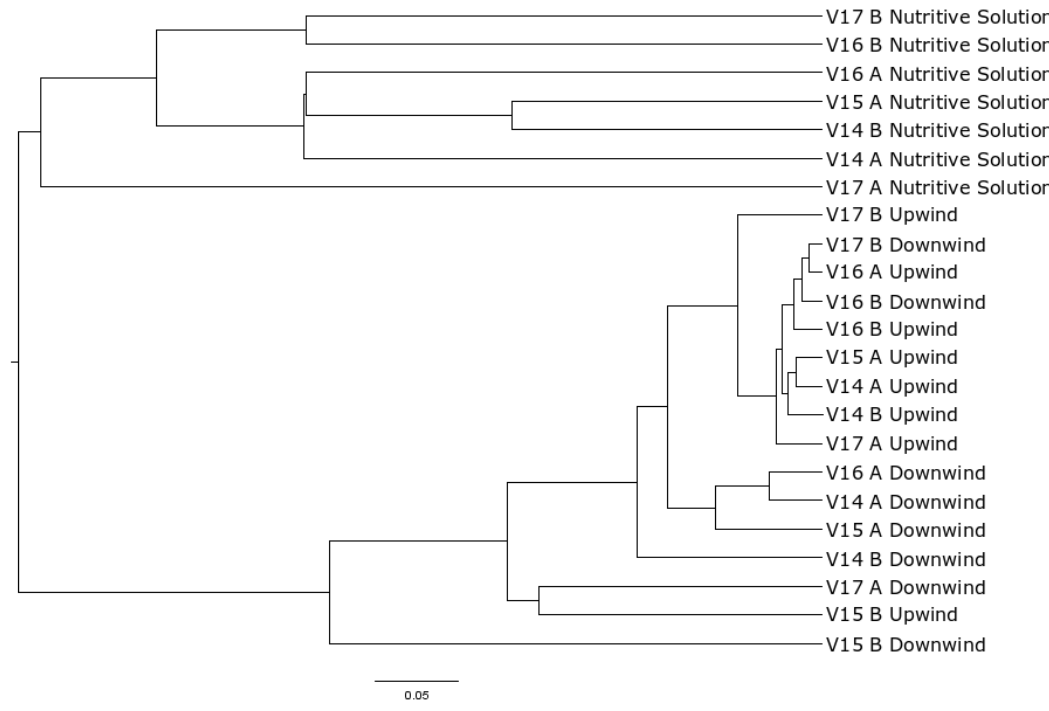
Figure 2. Dendrogram of samples. V## identifies the visit, A or B identifies the unit for upwind, downwind, and nutritive solution samples.